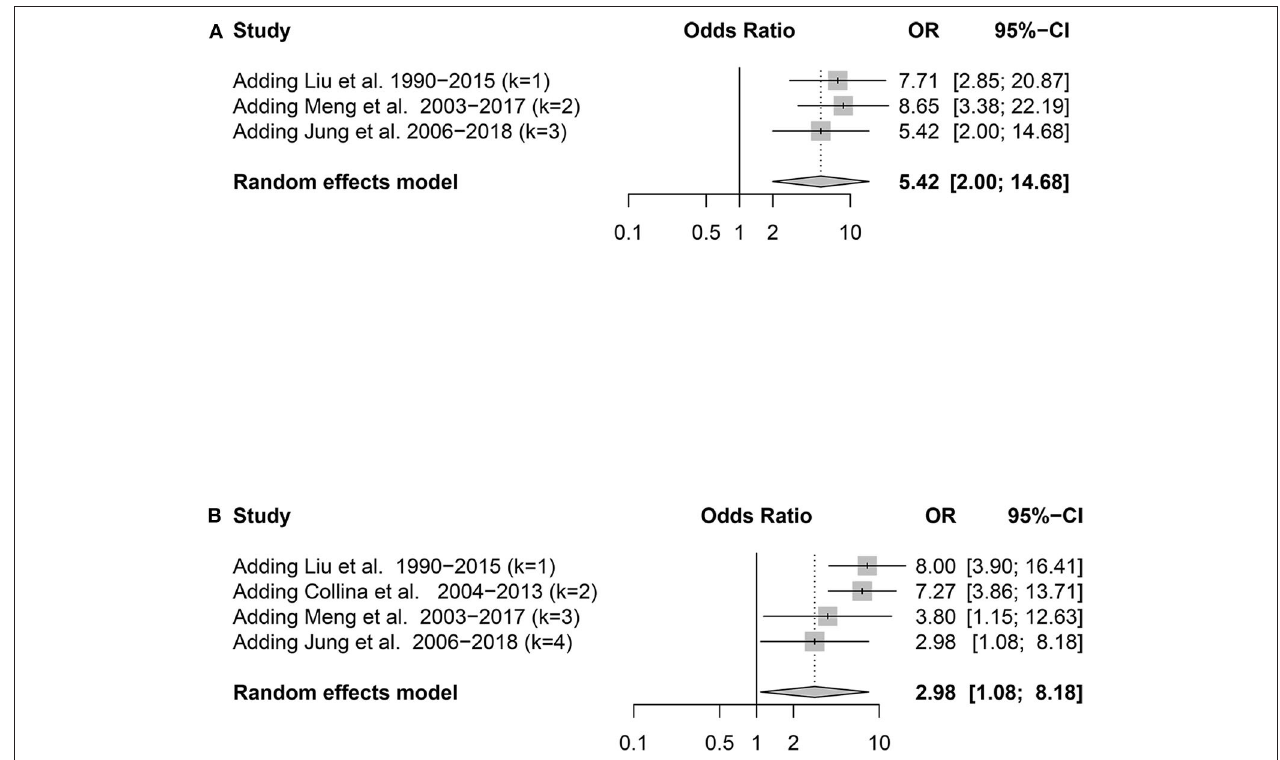
FIGURE 5 | Forest plot detailing the odds ratios with 95% confidence intervals for the effect of TERT promoter mutation (A) and BRAF V 600 E mutation (B) in the cumulative